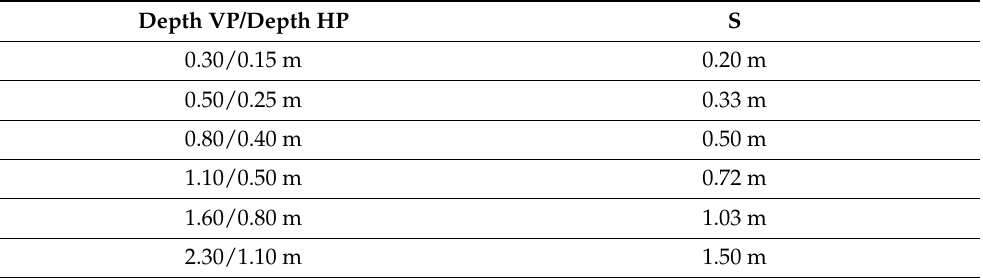
Table 1. Maximum study depths reached by CMD MiniExplorer 6L meter for the different separations (S) between T x and R x coils. VP = Vertical Polarization, HP = Horizontal Polarization.